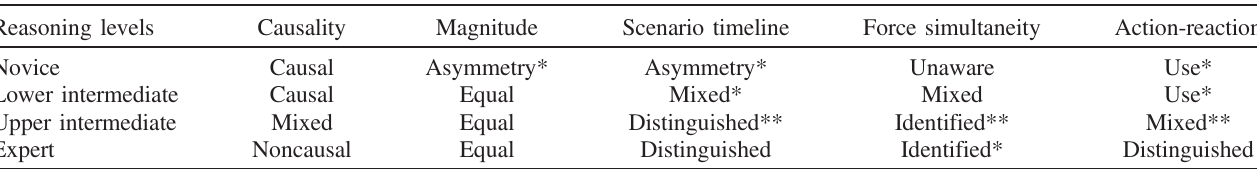
TABLE VIII. Students ’ reasoning pathways at different developmental levels. Factors of reasoning marked with a single asterisk (*) are used in determining causality. Factors marked with double asterisks (**) represent mixed usage meaning that they are sometimes used in determining causality. Unmarked factors are not used in determining causality. The determination of use is based on if the related factors are explicitly stated in the “ because ” part of an explanation.